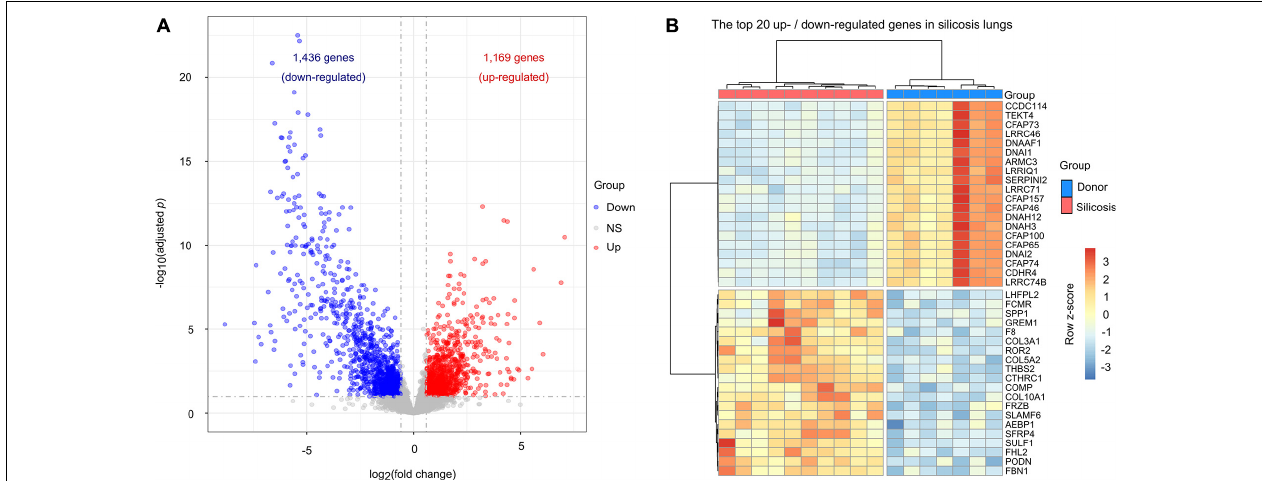
FIGURE 1 | Transcriptional differences between the lungs of silicosis patients and non-diseased donors. (A) Volcano plot showing the significantly altered genes in silicosis lungs. Blue dots represent down-regulated genes, red dots indicate up-regulated genes, and gray dots indicate genes with no significant change. (B) Heatmap illustrating the top 20 most up- or down-regulated genes in the lungs of silicosis patients. Each row represents a gene, and each column a sample. The expression level of each gene was normalized using row z-score. Red indicates higher expression levels and blue indicates lower expression levels. NS, no